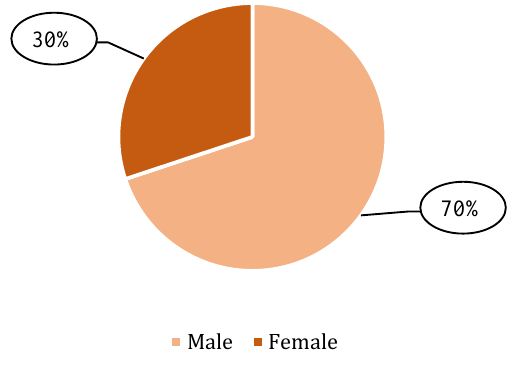
Figure 2: Composition of respondents’ Gender